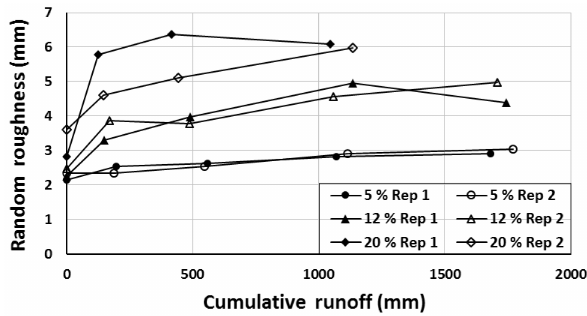
Figure 3. Averages of the three cross-section (lower, middle, and upper) laser-measured random roughness measurements (mm) as a function of cumulative runoff for the six